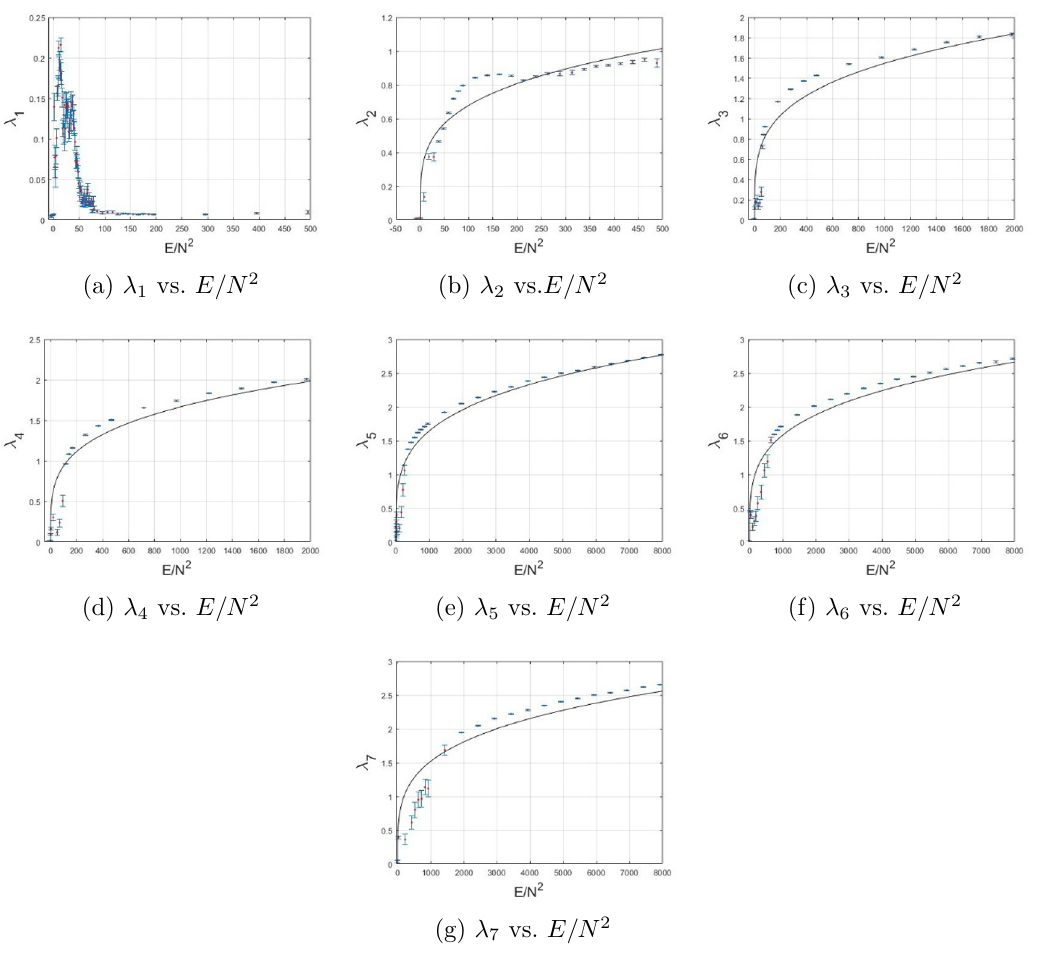
Figure 4. MLLE vs. E=N 2 for (cid:22) 2